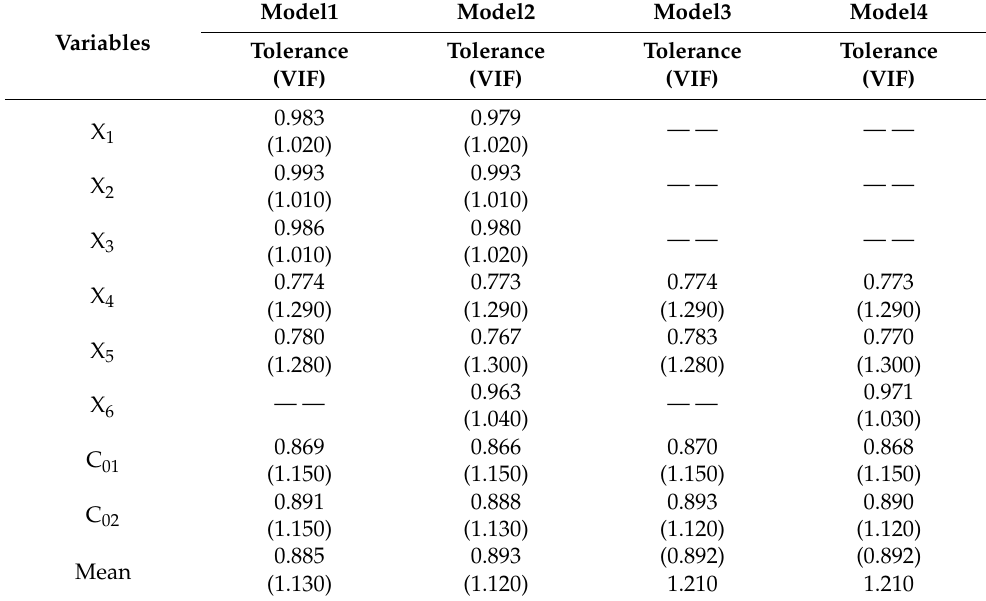
Table 8. Multicollinearity test